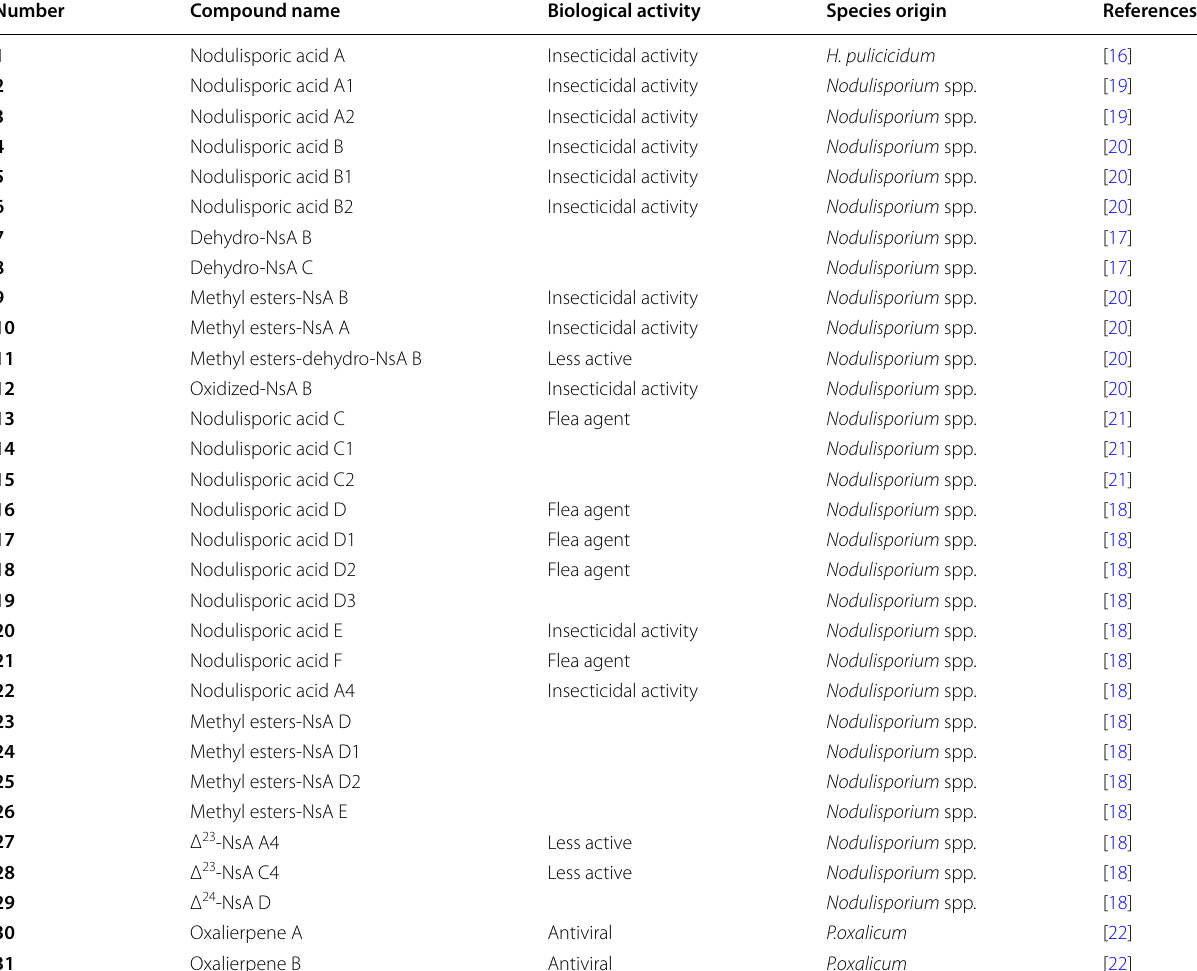
Table 1 Name, bioactivities and source of nodulisporic acid